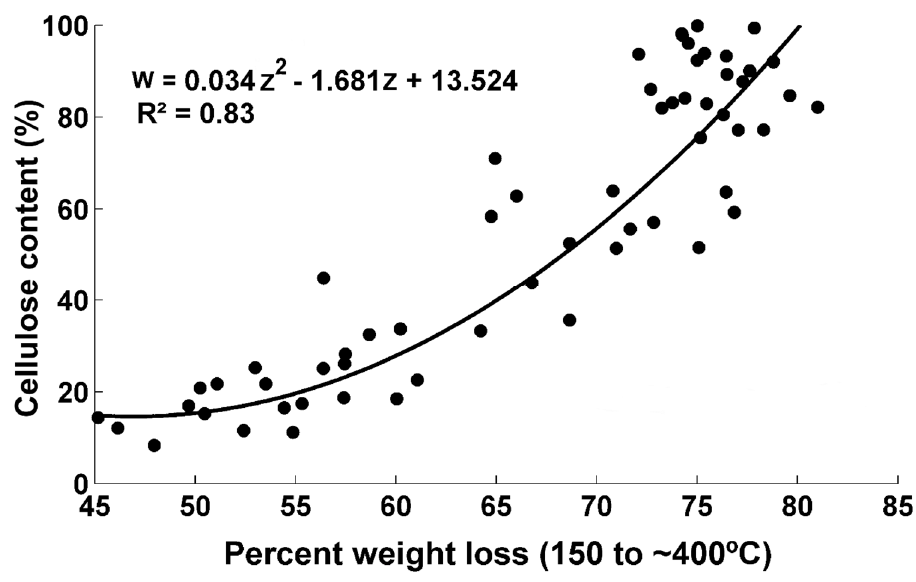
Figure 11. Cellulose content as a function of weight loss in the region from 150 to 400 °C.